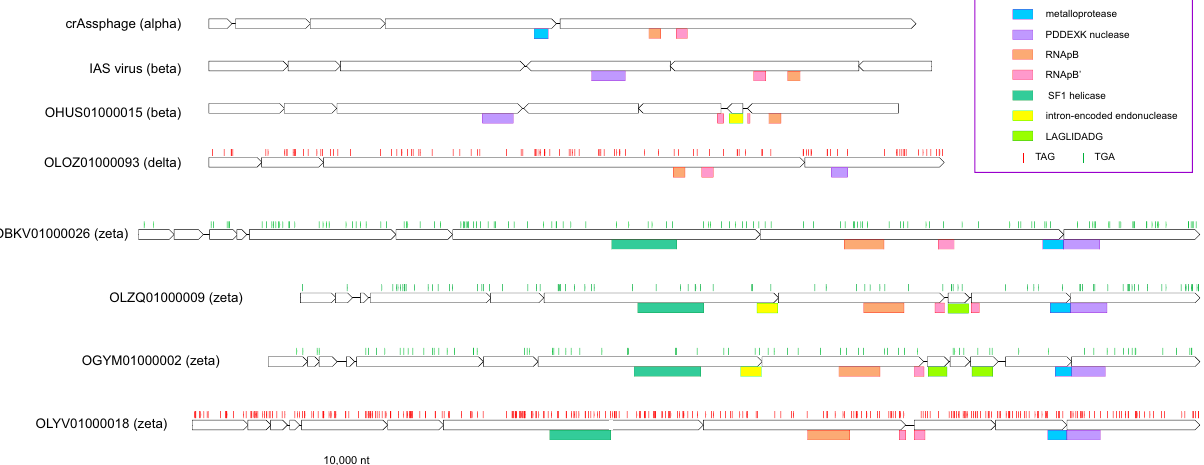
Fig. 3 Transcription gene block in crAss-like phages. The predicted genes are shown by empty block arrows, and recognized conserved domains are indicated by colored rectangles. Vertical bars indicate in-frame stop codons. LAGLIDADG is intron-encoded endonuclease